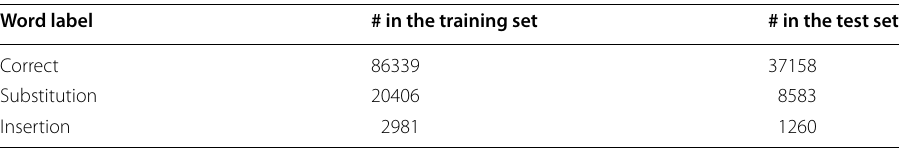
Table 2 Words label distribution in the training and test sets Word